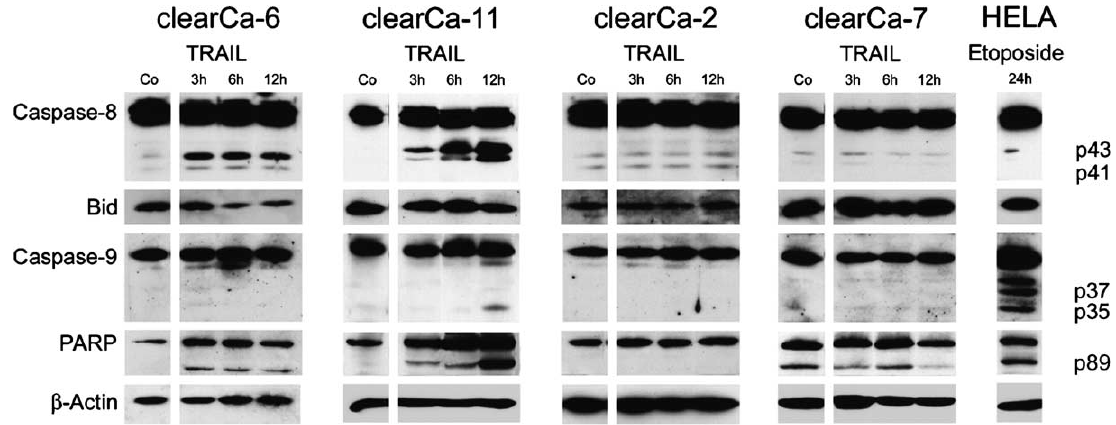
Fig. 2. Western Blot analysis of caspase-8-, caspase-9- and PARP-cleavage as well as Bid reduction after exposure to TRAIL. Increased detection of active cleavage products of initiator caspase-8 (p43 and p41) as well as PARP (p89) after exposure to rhs TRAIL in the sensitive cell lines clearCa-6 and clearCa-11 after 3, 6 and 12 h as markers for increased apoptosis. Weak reduction of Bid protein concentration only in clearCa-6. Weak and late caspase-9 cleavage (after 12 h) only in clearCa-11. No caspase-8-cleavage or PARP activation as well as Bid cleavage in the resistant cell lines clearCa-2 and clearCa-7. (HELA cells treated with 25 µg/ml etoposide for 24 h were used as positive control for caspase-9 and PARP cleavage.) RCC cell lines by etoposide, HA14-1 or betulinic